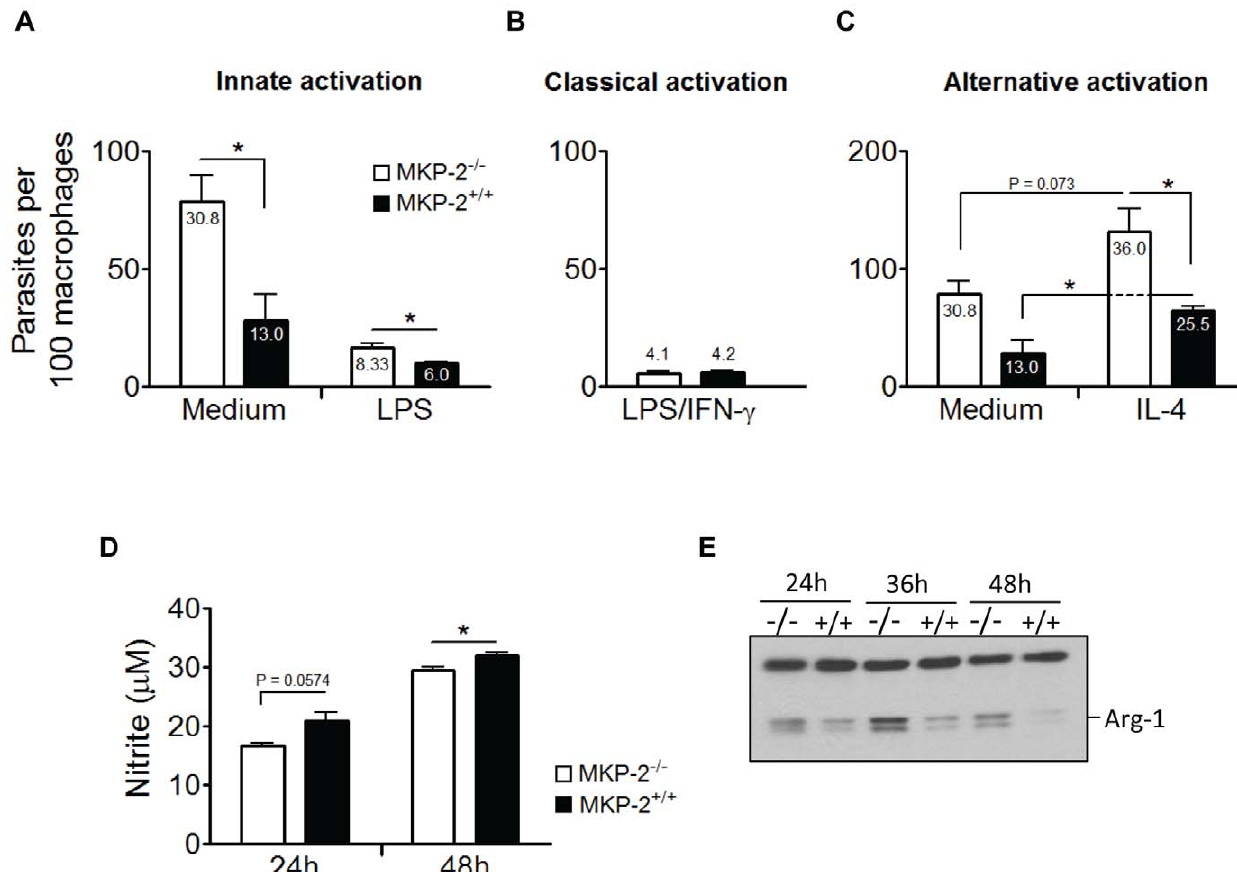
Figure 2. Macrophages of MKP-2 2 / 2 mice are inherently more susceptible to L.major parasites. Bone marrow-derived macrophages of MKP-2 2 / 2 (open symbols) and MKP-2 + / + (closed symbols) grown on cover slips were infected with L. major promastigotes at a multiplicity of infection (MOI) of 5. One hour after infection free parasites were removed by washing and medium was replaced with complete RPMI supplemented with or without 100 ng/ml LPS or a combination of 100 ng/ml LPS and 100 U/ml IFN- c , or 100 U/ml IL-4 and left for 24 or 48 h at 34 u C (A, B and C respectively). Macrophages were fixed in methanol and stained with Giemsa. Intracellular parasites were counted in a total of 200 macrophages using a bright field microscope and are shown as number of parasites per 100 macrophages. The mean percentage of infected macrophages is also expressed as numbers inside the columns. At time points indicated supernatants from LPS-stimulated macrophages were removed and tested for nitric oxide production using Griess reagent (D). Error bars show standard error of the mean (SEM). The data shown is representative of at least three independent experiments. For analysis of Arginase-1 expression 1 6 10 6 BMDM were infected at an MOI of 5 and whole cell lysates were run on 12% gels, blotted on nitrocellulose membranes and stained for Arginase-1. The top cross-reactive band serves as loading control